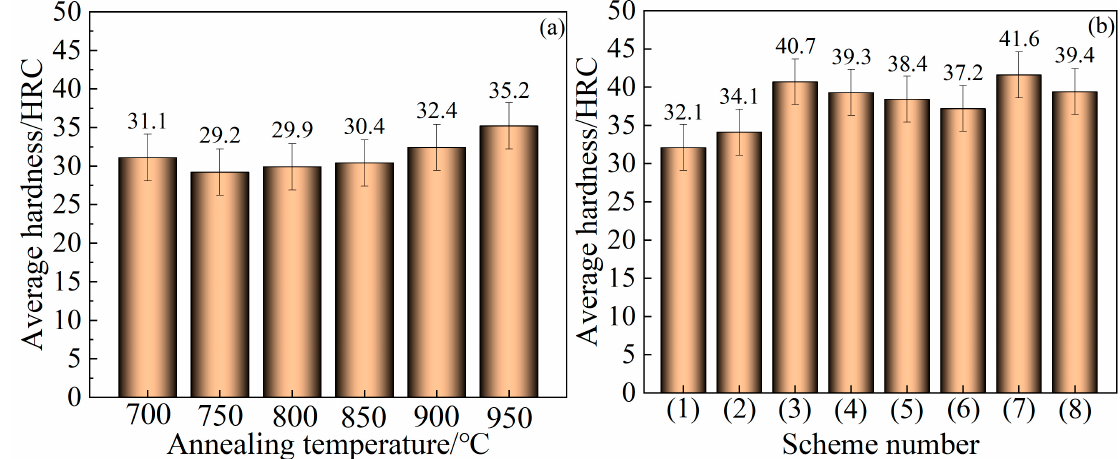
Figure 16. Hardness comparison after the heat treatment: ( a ) annealing; ( b ) solution-aging.